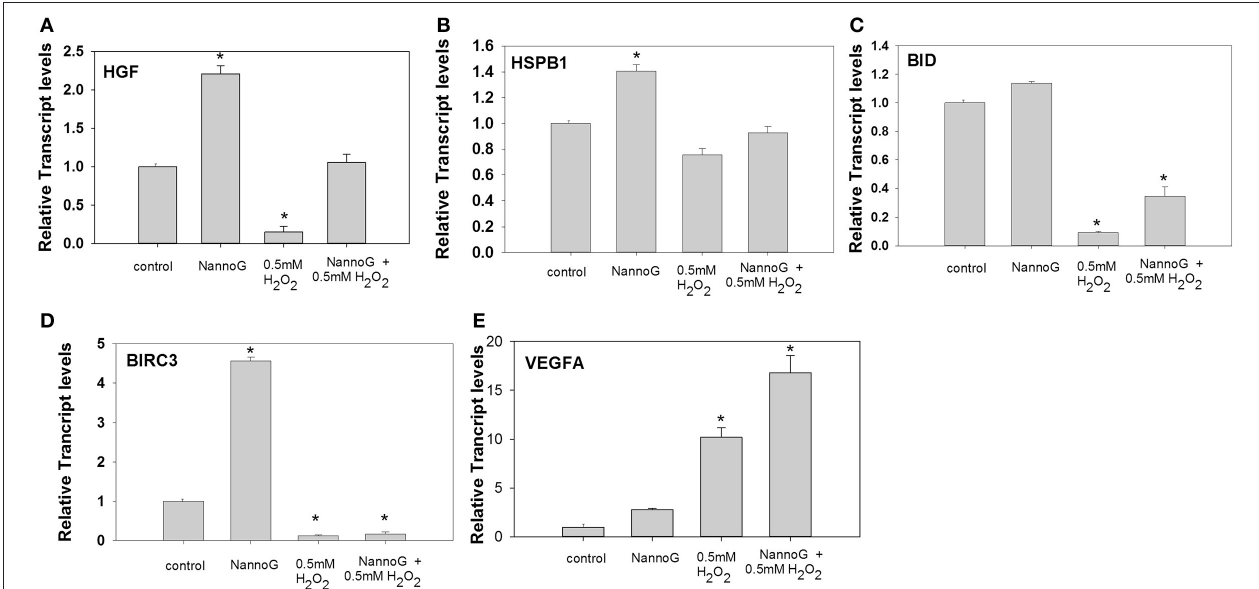
FIGURE 5 | Relative transcript accumulation for: (A) HGF, (B) HSPB1, (C) BID, (D) BIRC3, (E) VEGF α . The experimental conditions are: control cells, cells treated with H 2 O 2 0.5 mM, cells treated with NannoG (408 µ g/ml) and cells treated with NannoG first and then with H 2 O 2 (0.5 mM). * p < 0.05 significantly different from the